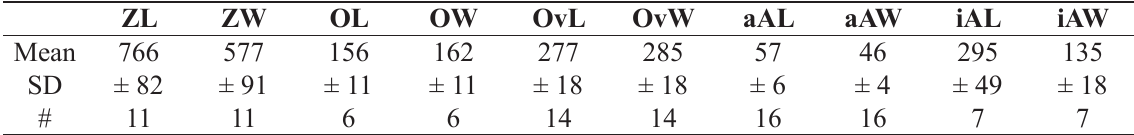
Table 12. Measurements of Bathycyclopora suroiti gen. et sp.